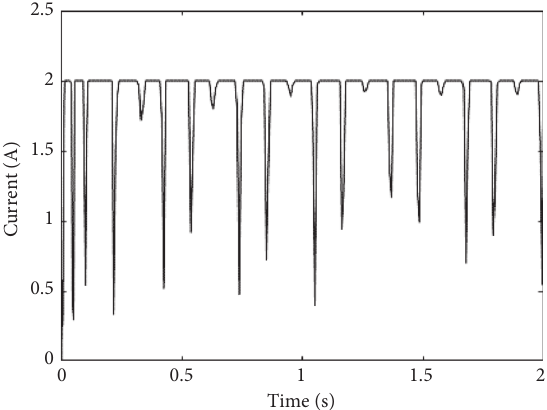
Figure 10: Current used to control the semiactive